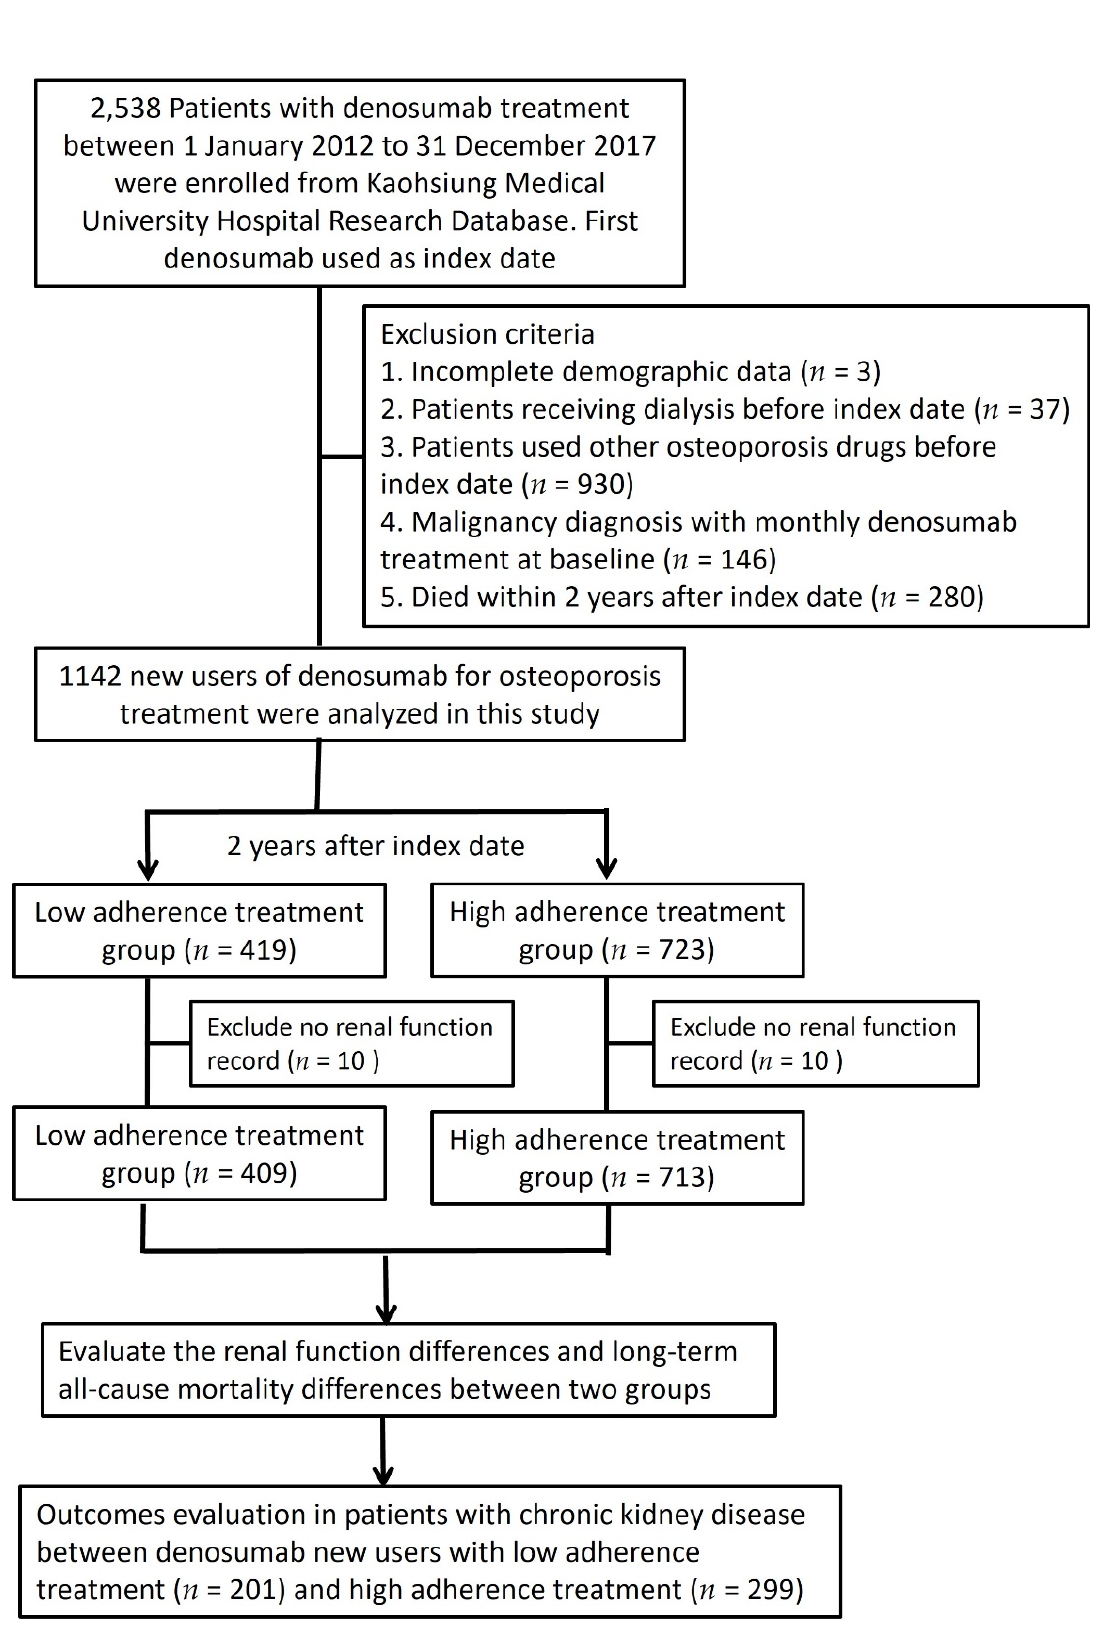
Figure 1. Study flowchart.